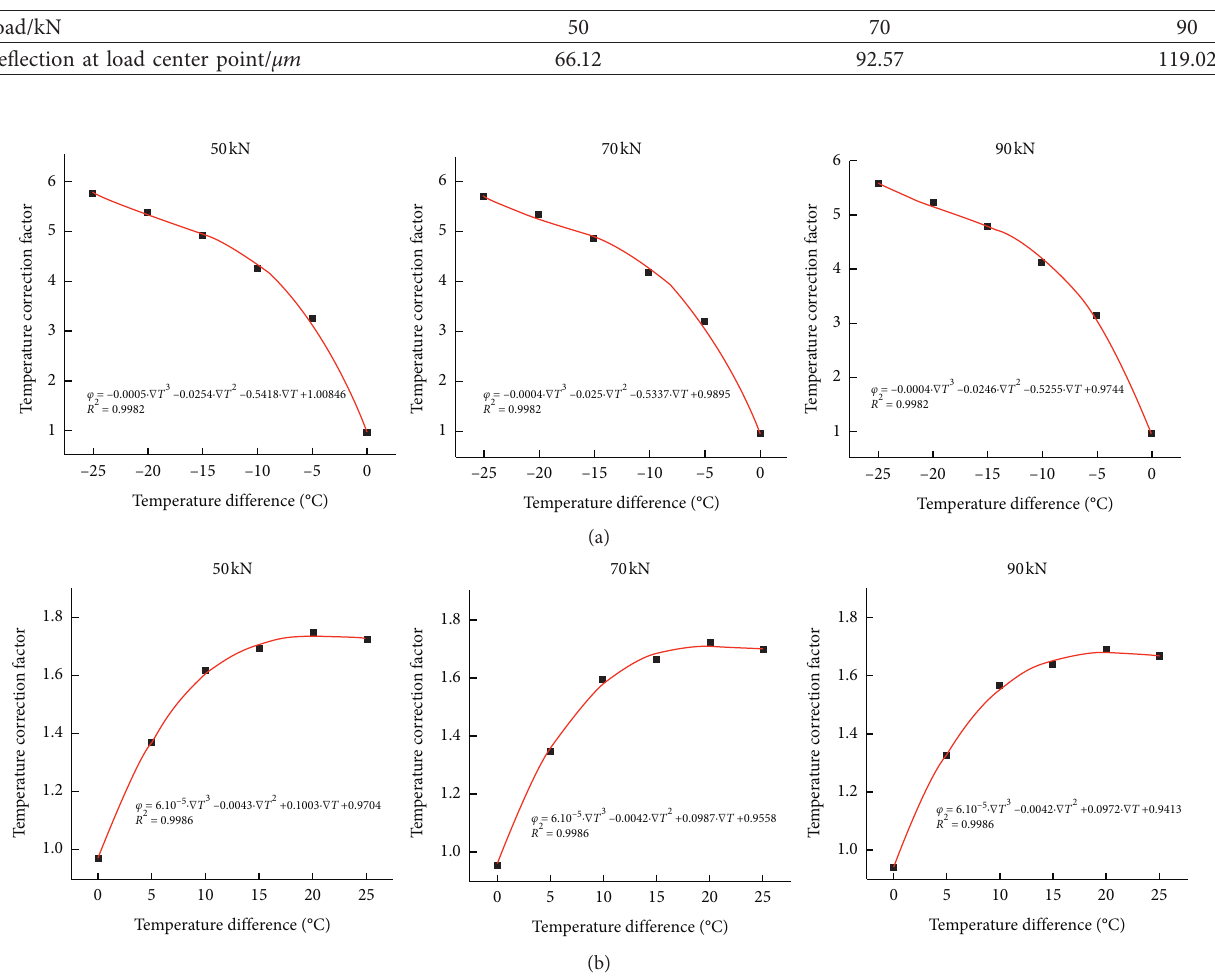
Figure 6: Correlation between temperature difference and correction coefficient under three loads. (a) Negative temperature range. (b) Positive temperature